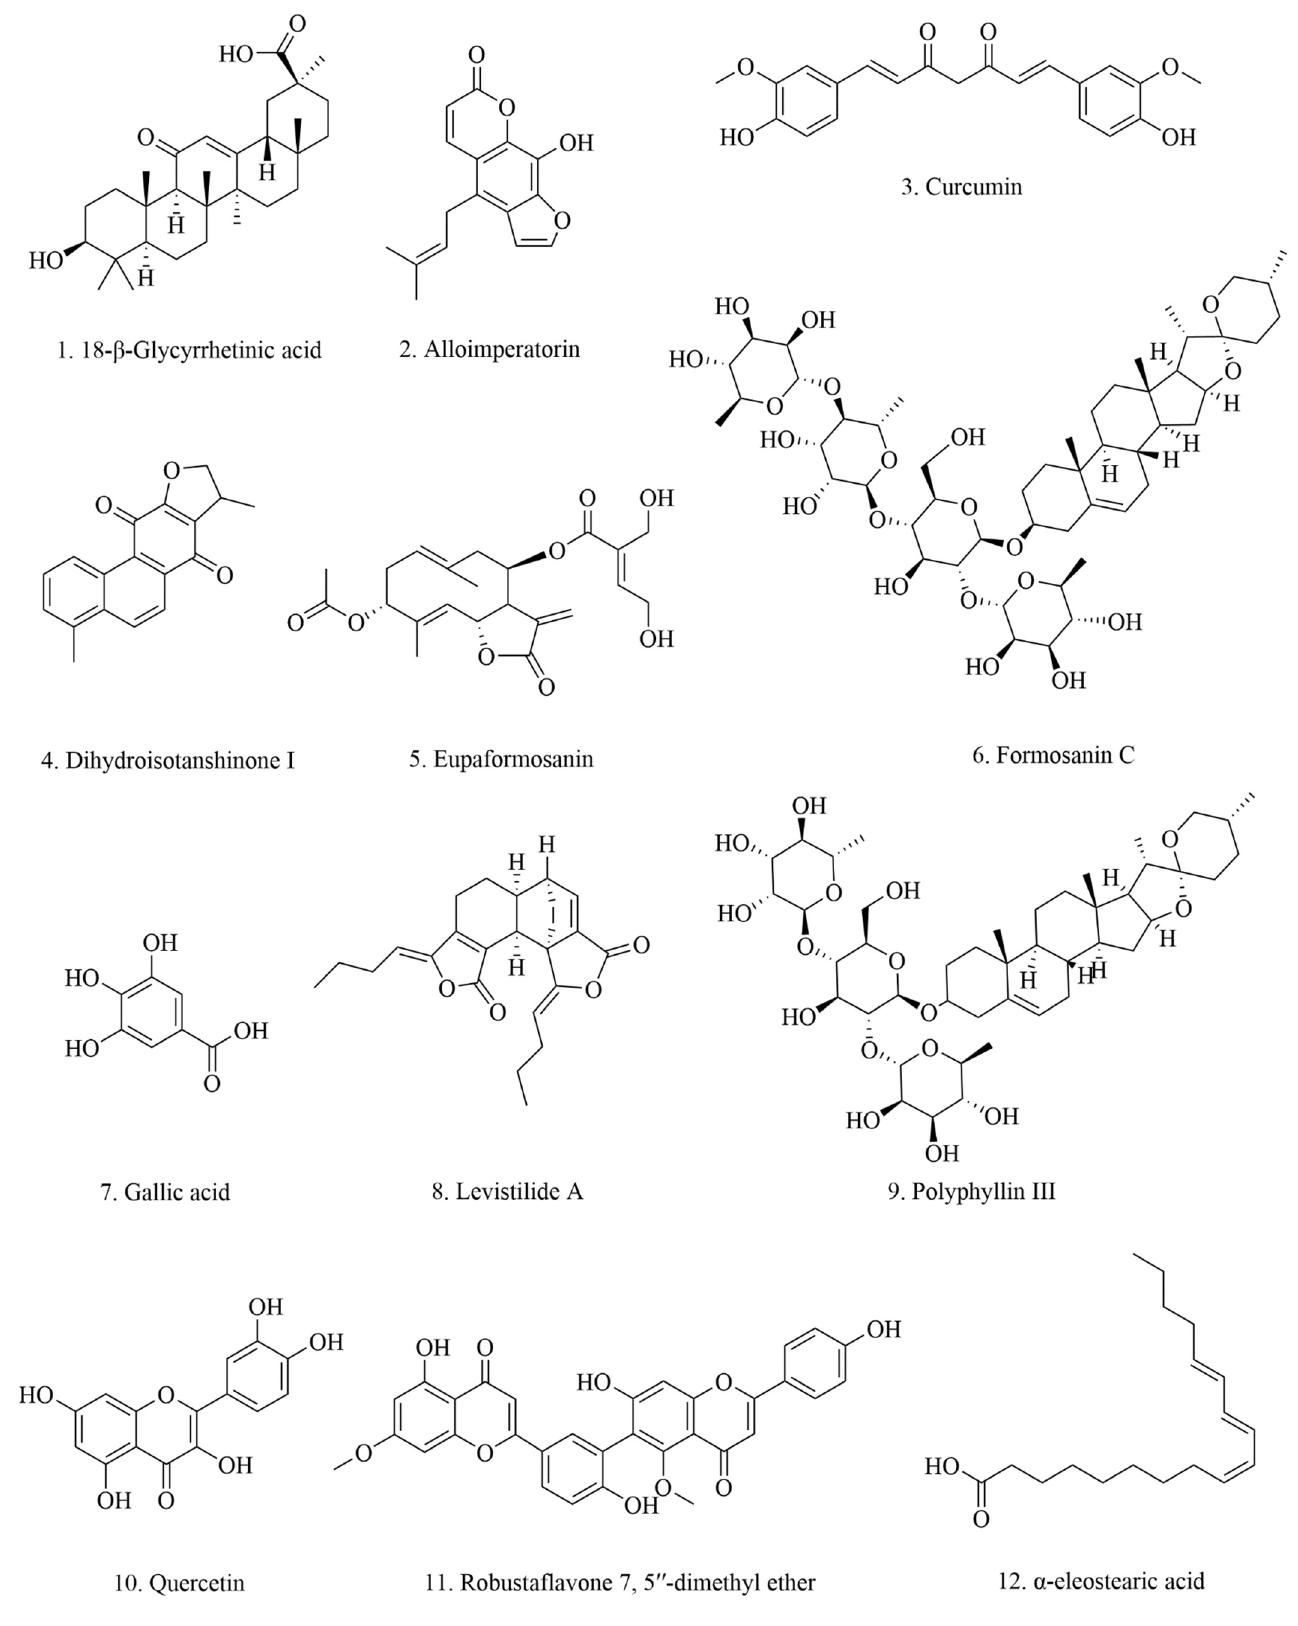
Figure 2. Chemical structures of phytochemicals in Table 1.